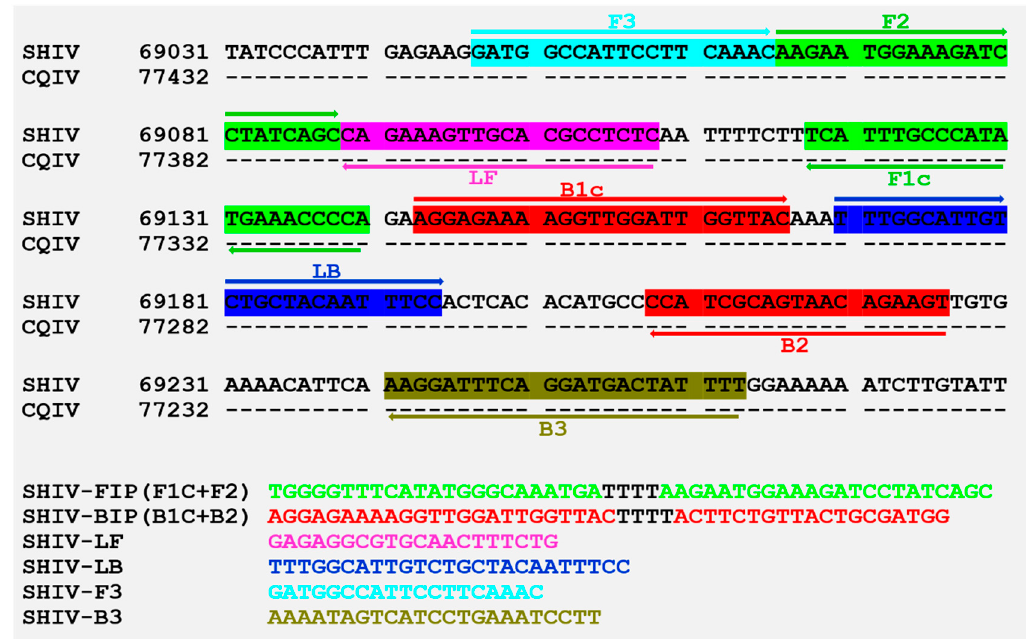
Figure 5. Information on primer design and primers used for Loop-mediated isothermal amplification (LAMP), based on the reference sequence of DIV1. Sequences of Shrimp hemocyte iridescent virus (SHIV 20141215 MF599468) and Cherax quadricarinatus iridovirus (CQIV CN01 MF197913) were obtained from GenBank.